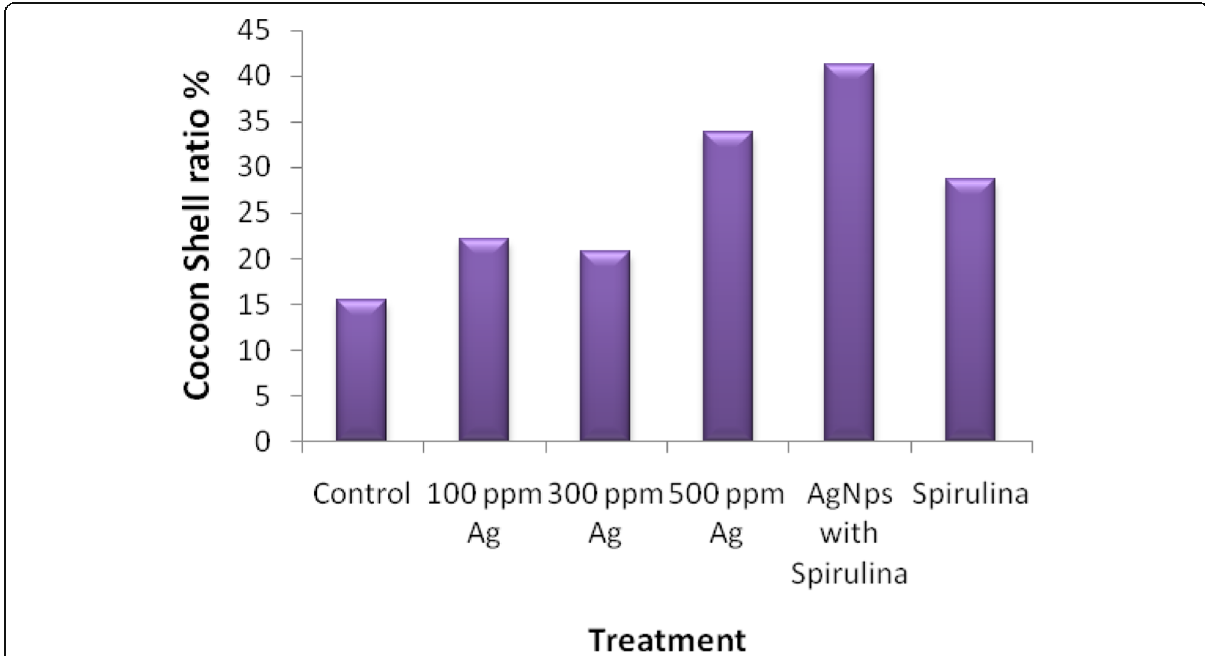
Fig. 5 Cocoon shell ratio % of the AgNPs and Spirulina-treated groups